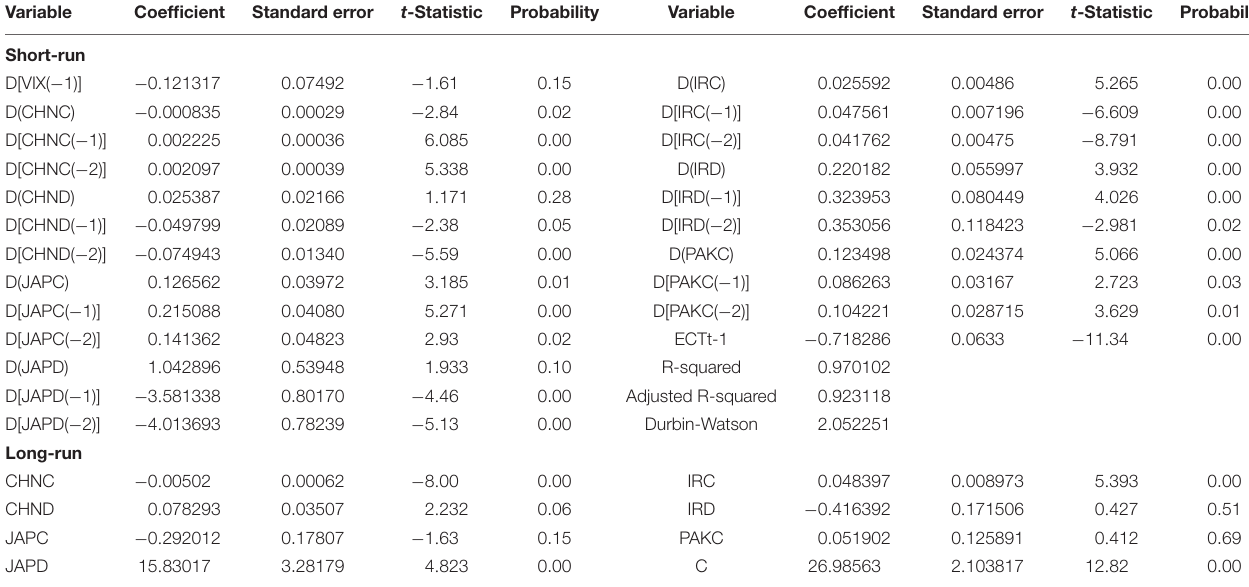
TABLE 6 | Long-run and short-run parameters of ARDL model